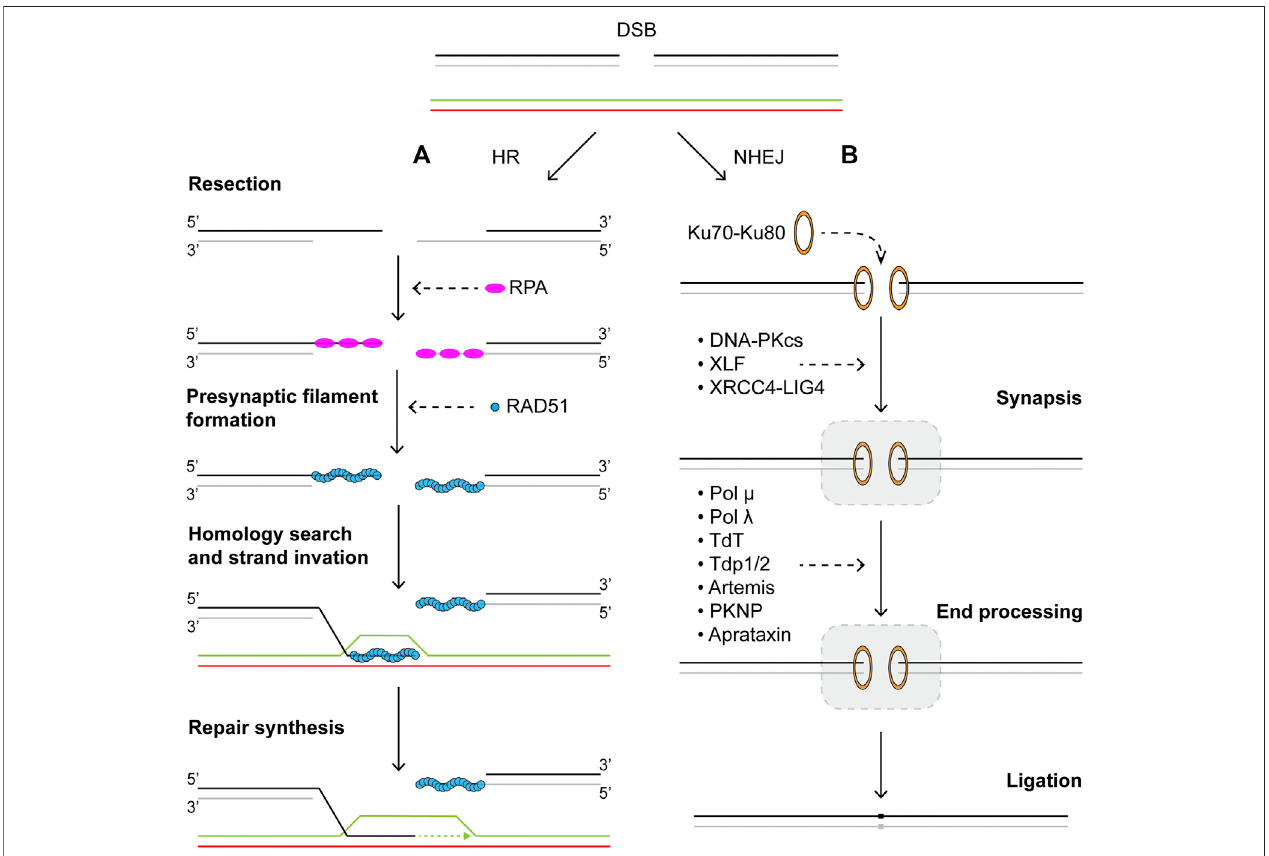
FIGURE 2 | Repair of DNA double strand breaks via (A) homologous recombination or (B) nonhomologous end-joining pathways. Schematics of homologous recombination and nonhomologous end-joining pathways. See main text for details.